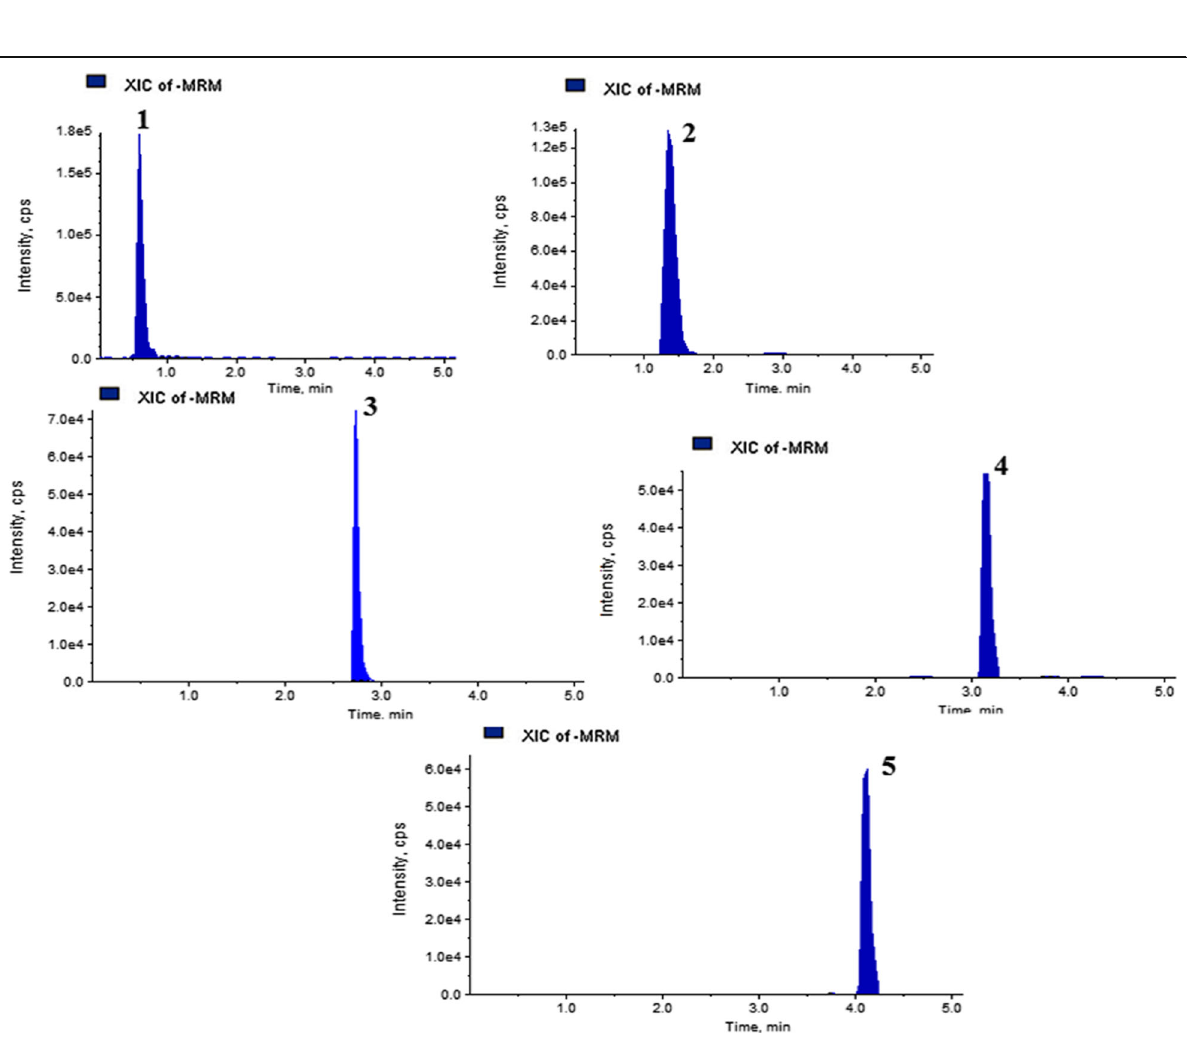
Fig. 6 Extracted ion chromatograms (XICs) of five pairs of standard bioactive compounds obtained by UPLC-ESI –